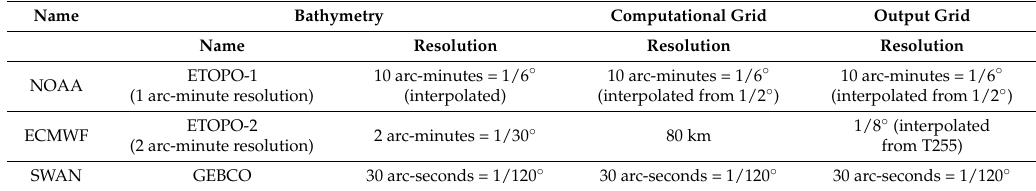
Table 3. Bathymetry and the computational resolution.